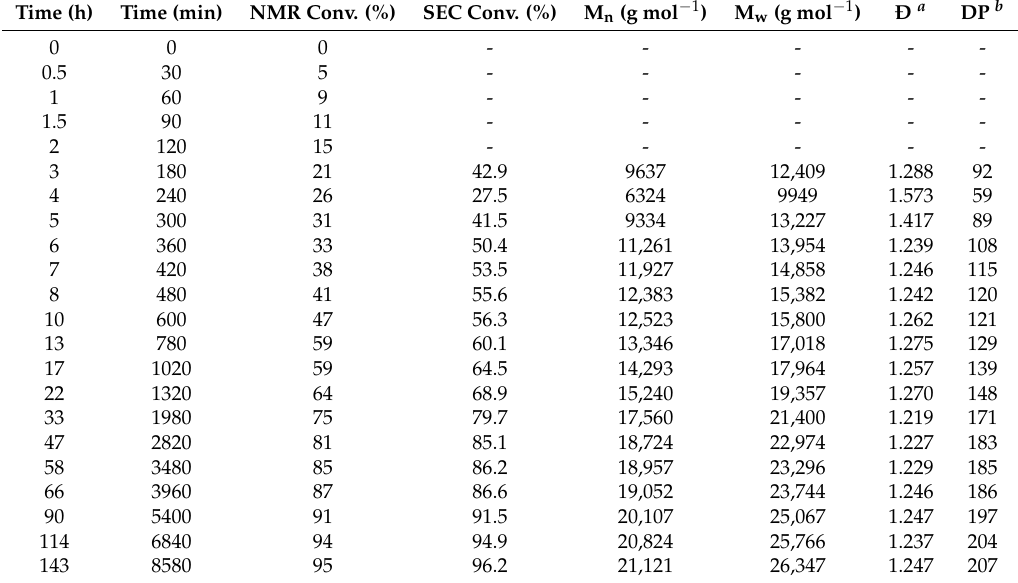
Table A1. Summary of 1 H NMR and SEC data for PMMA-1.